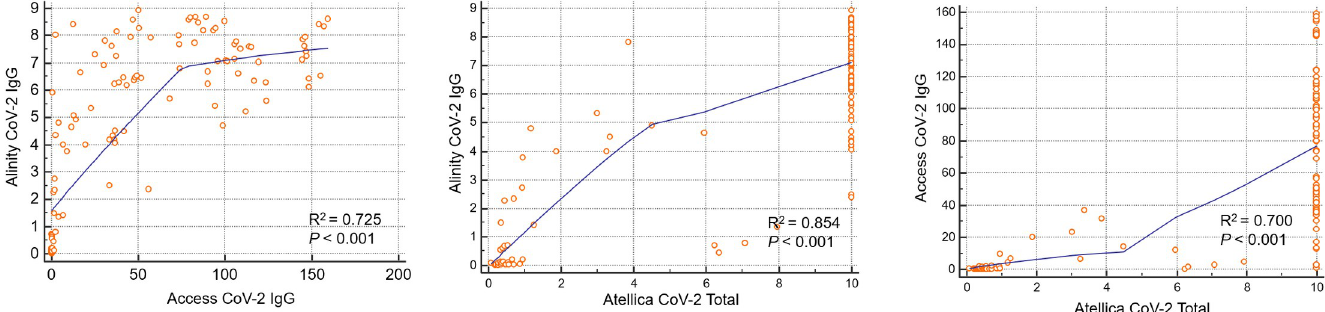
Fig 2. Pearson’s correlation coefficient r and p-value between S/CO index of the three automated immunoassays. Alinity CoV-2 IgG, Access CoV-2 IgG, and Atellica CoV-2 Total antibody presented strong correlations.